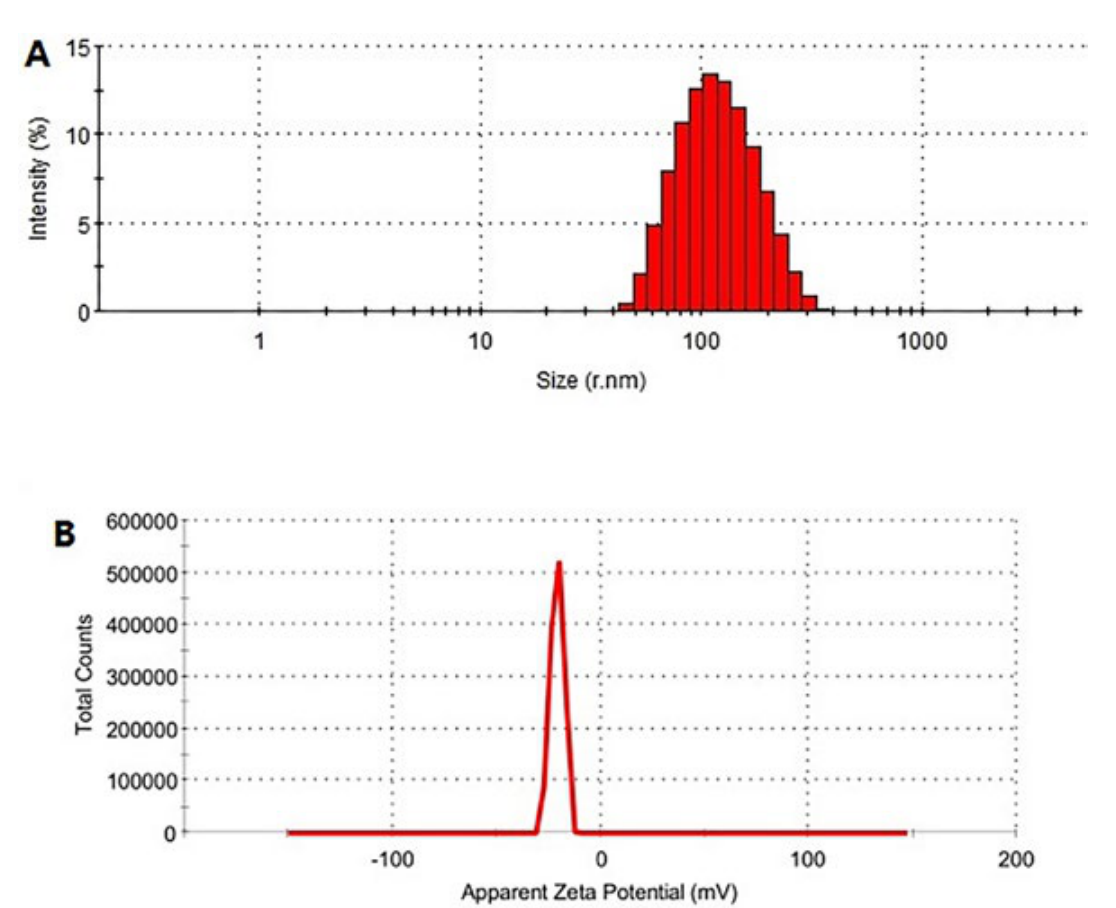
FIGURE 1 - Particle size and zeta potential of 2-ME-PSL.